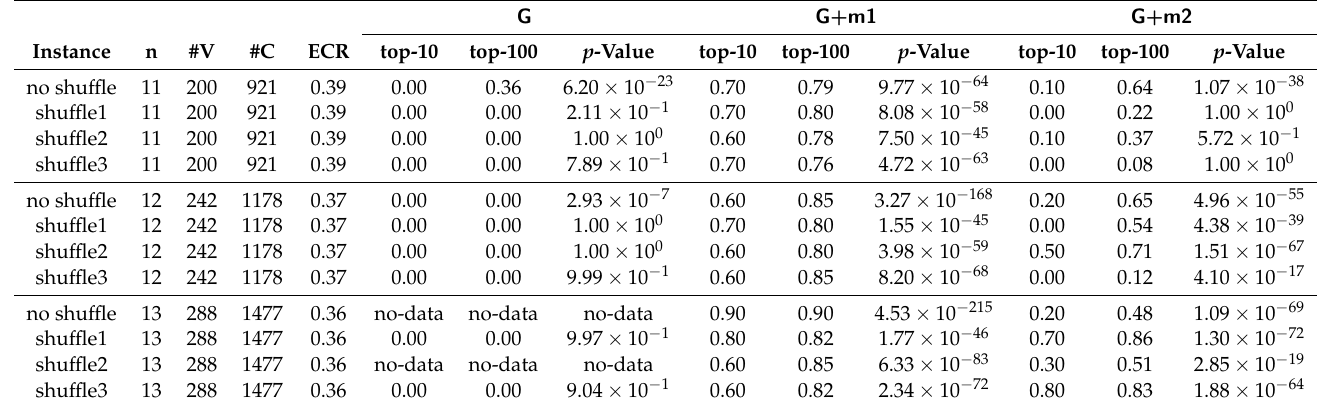
Table 5. DRUP analysis results of PHP instances with full extension for Glucose.